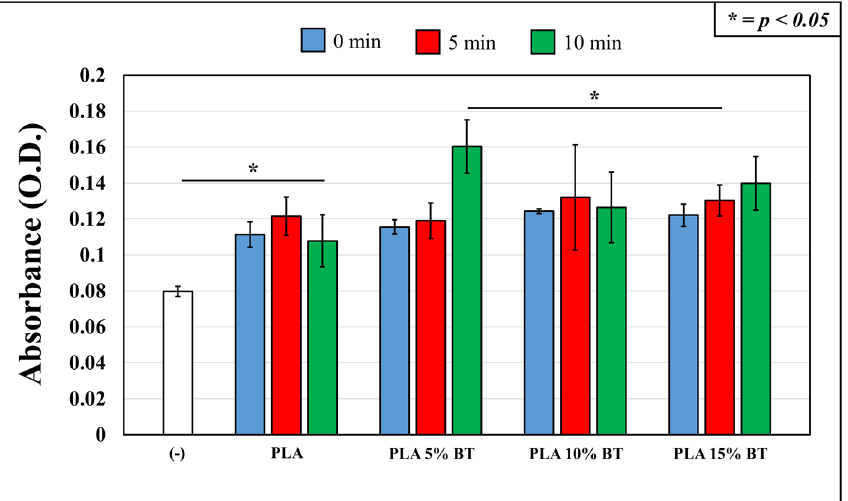
Figure 9. Cell viability assessed by Cell Count Reagent SF kit on the four samples before and after aging treatment using human dermal fibroblasts (HDF) cells and validated by statistical